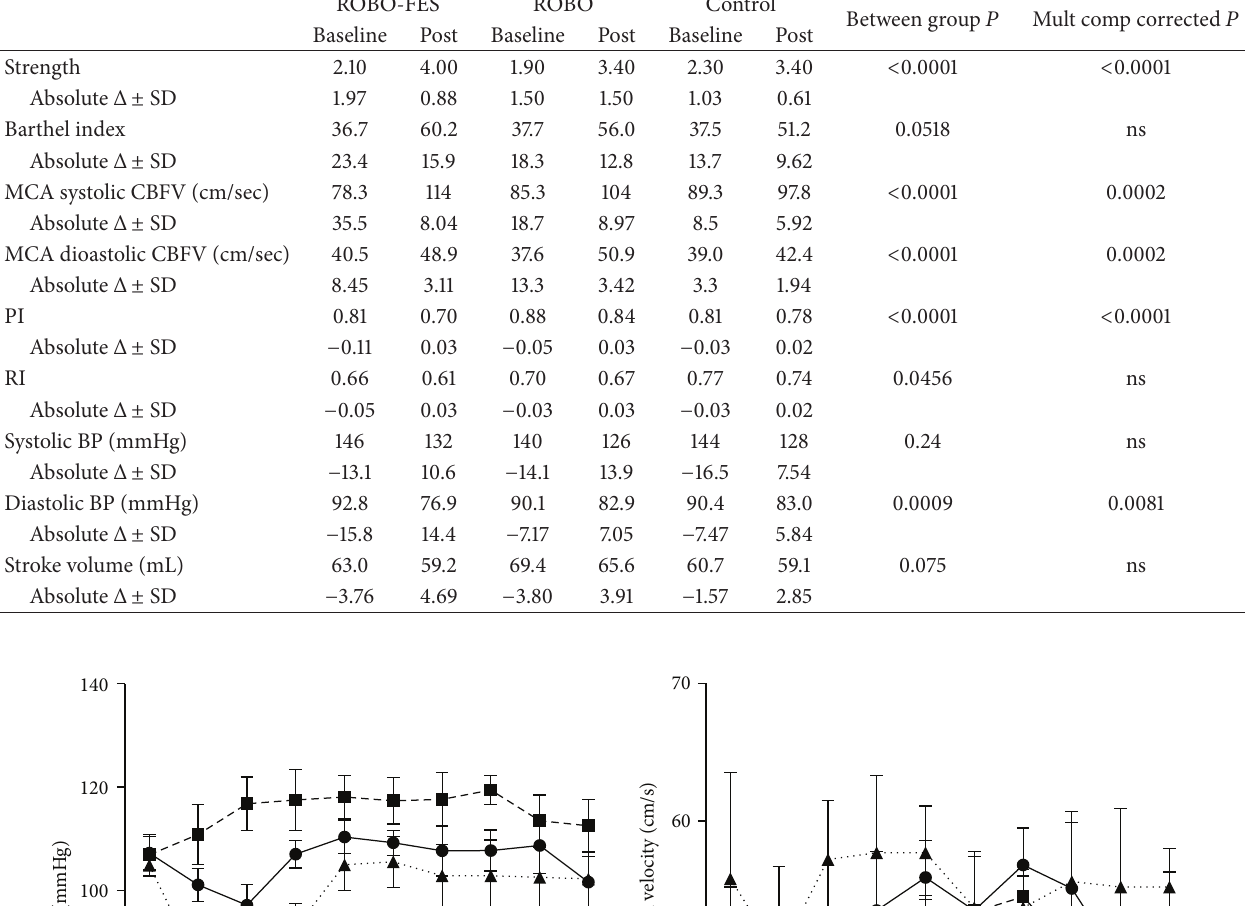
Between group 𝑃